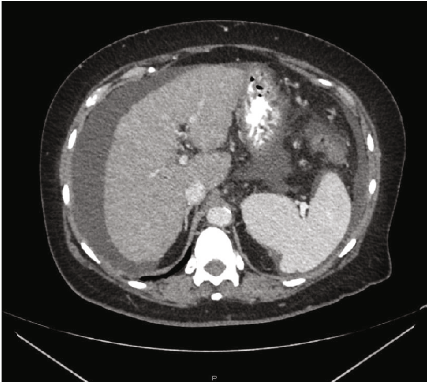
Figure 1: CT demonstrating ascites and mildly nodular liver surface contour (oral and IV contrast present).